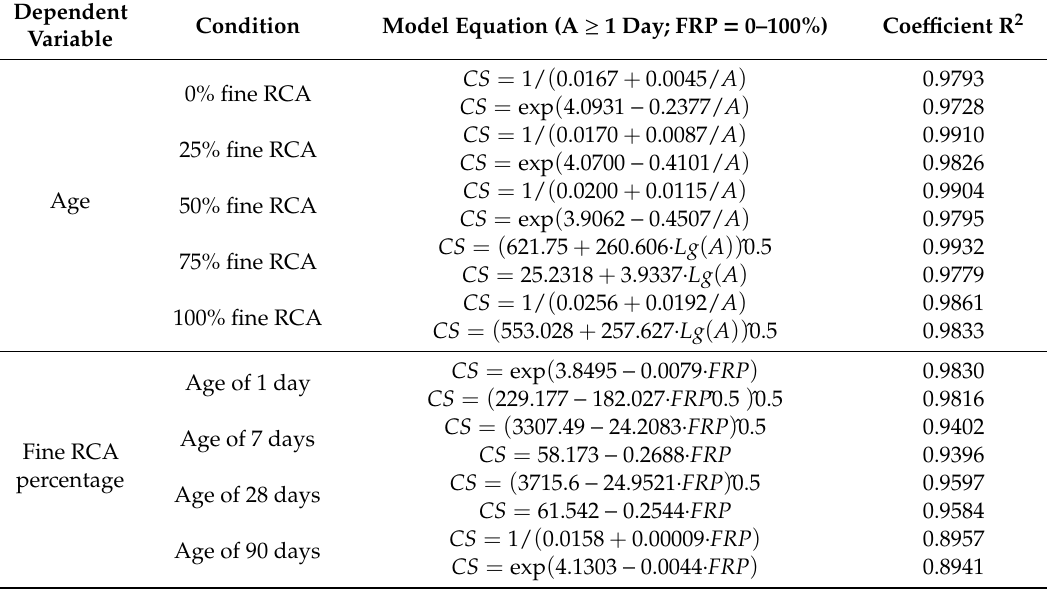
Table 13. Best-fit models of compressive strength as a function of the fine RCA percentage and